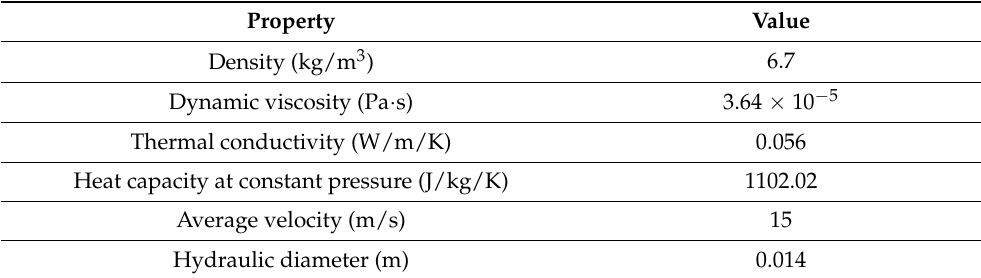
Table 5. Properties of the